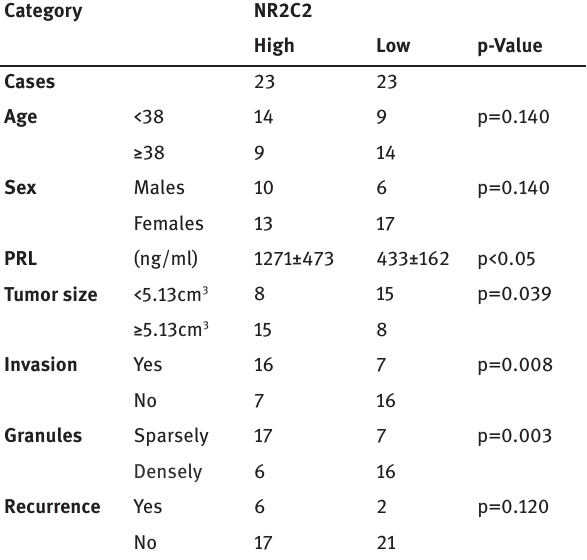
Table 2: Relationship between NR2C2 and various clinical parameters in 46